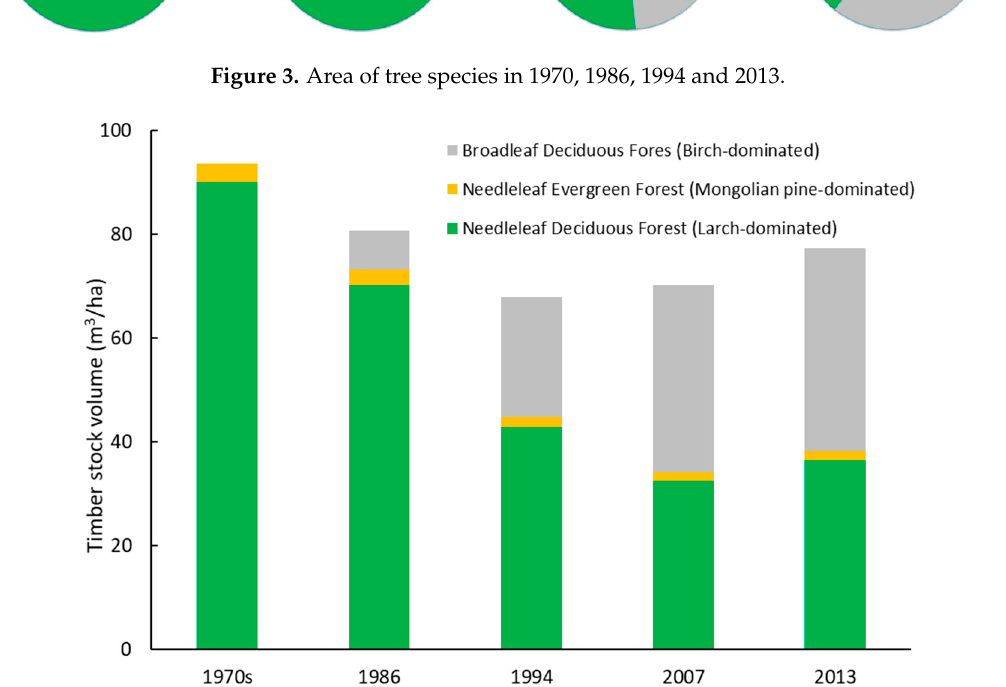
Figure 4. Timber stock volume per hectare of the three forest types in the 1970s, 1986, 1994, 2007 and 2013.